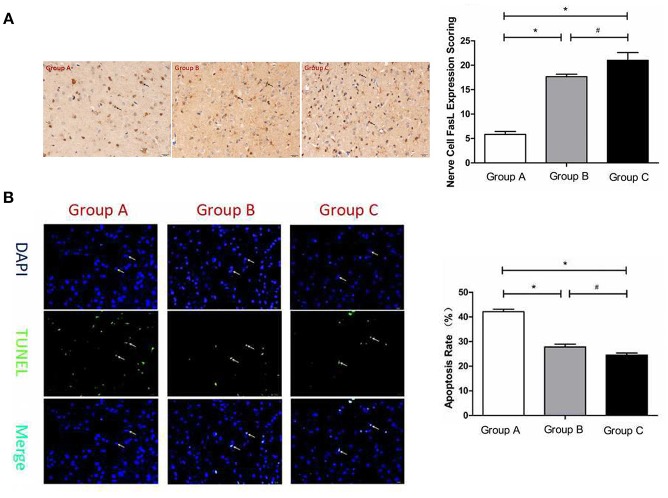
(A) FasL expression scoring of nerve cells measured at 21 d after SBI. *compared with Group A, P < 0.05; #compared with Group B, P < 0.05. The black arrows indicate positive results (the brown cells). (B) TUNEL assay of the nerve cells. *compared with Group A, P < 0.05; #compared with Group B, P < 0.05. DAPI (blue) was used to indicate the nuclei (arrows), and TUNEL (green) was used to indicate the apoptotic signals (arrows). The merge indicates the apoptotic cells (arrows). The scale bars are 20 μm.